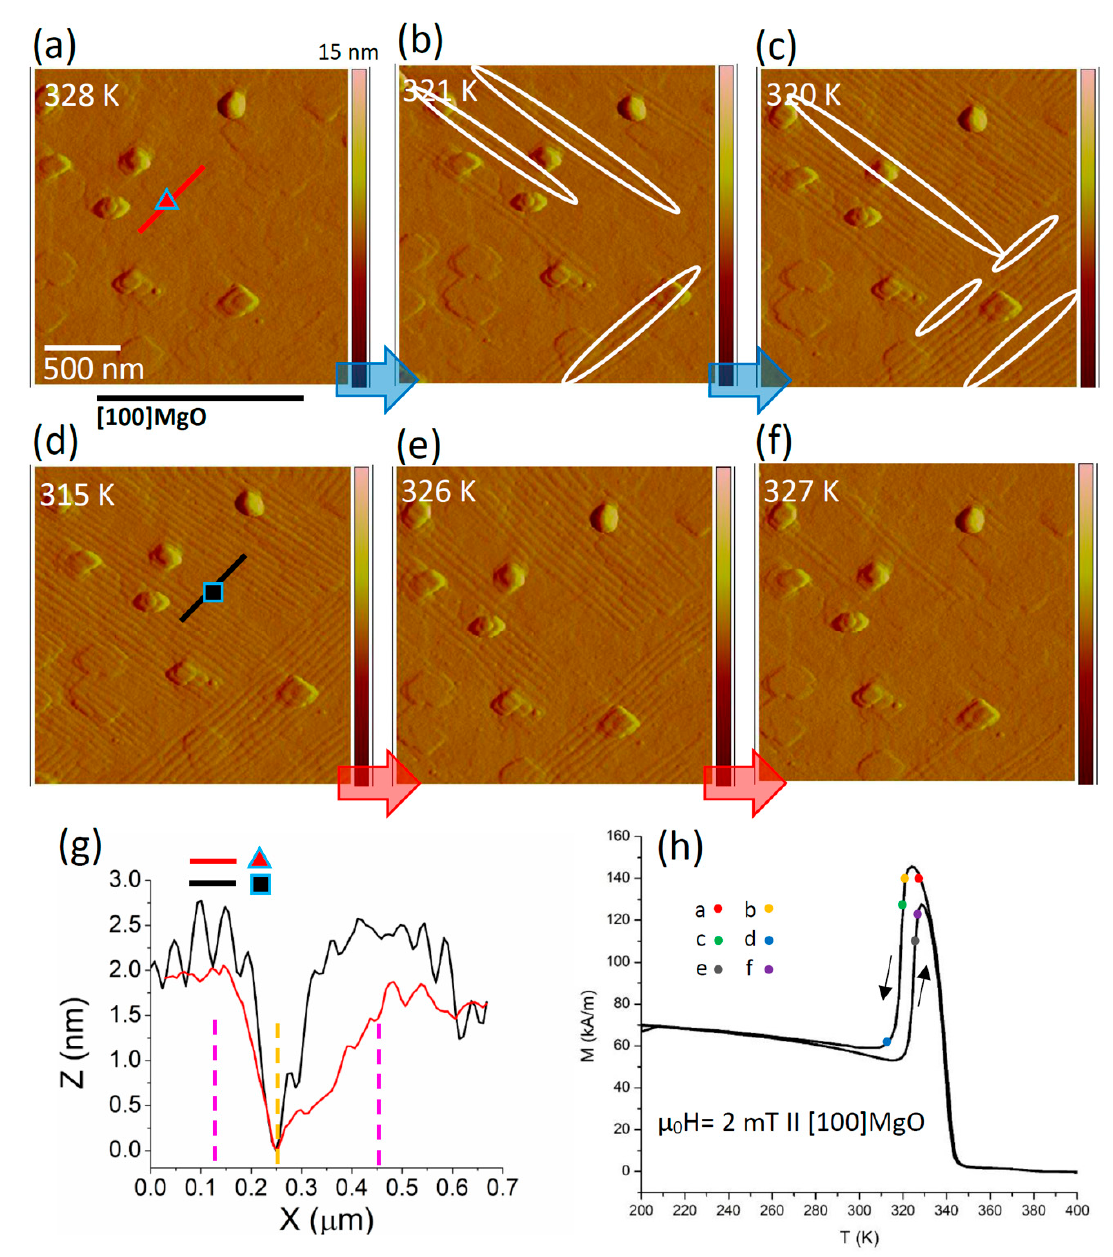
Figure 5. Tracing the formation and annihilation of the interfaces in sample #2 by means of in situ topography imaging vs. temperature. AFM images were captured in di ff erent stages of the forward and reverse transition (345K-300K-345K): ( a ) 328K, the film is in the austenitic phase; ( b ) 321K, nucleation of the martensitic phase starting from the ridges (conjugation interfaces), some are highlighted; ( c ) 320K, twin boundaries continue to nucleate and grow till they meet each other, the highlighted valleys and non-conjugation interfaces have not transformed yet; ( d ) 315K, the film is in the martensitic phase, the valleys and the non-conjugation interfaces have transformed as well; ( e ) 326K, the material transforms back to the austenitic phase starting from the valleys and the non-conjugation interfaces; ( f ) 327K, only the ridges are still untransformed; ( g ) height profile of the marked area (the two ridges and the valley are assigned by the pink and yellow dash-lines, respectively); ( h ) initial magnetization vs. temperature curve of the sample with schematic correspondence between the imaging temperatures and the curve.